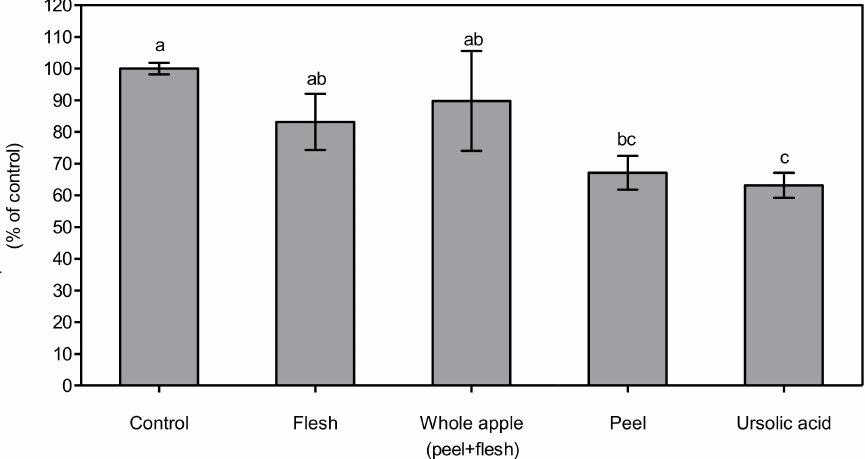
Figure 4. Lipid accumulation rate determined by Oil-Red O assay in 3T3-L1 cells treated with 70% methanol extract (1 µ g dry powder in 1 mL of DMSO) from peel, flesh, and whole apple (peel + flesh) samples, or ursolic acid 5 µ M-treated samples. The data are represented as % of lipid accumulation compared to control. The bar and error bar indicate mean and standard deviation ( n = 3). Different letters indicate significant differences among the groups according to Tukey’s HSD test at p <